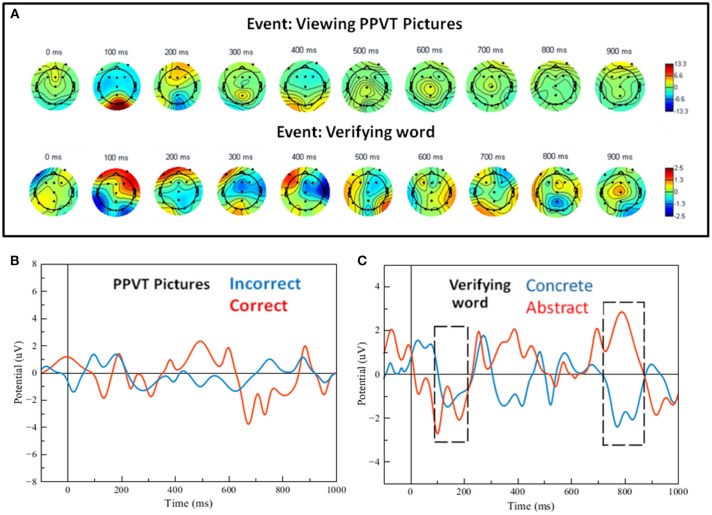
(A) Scalp maps for the word-verification task events (viewing pictures and verifying the word). (B) Filtered single-trial ERP waveforms of correct vs. incorrect word-verification trials at electrode FZ. (C) Filtered single-trial ERP waveforms for the verification of concrete and abstract words; the gray dashed-line frames show regions of significant effects (see details in text).